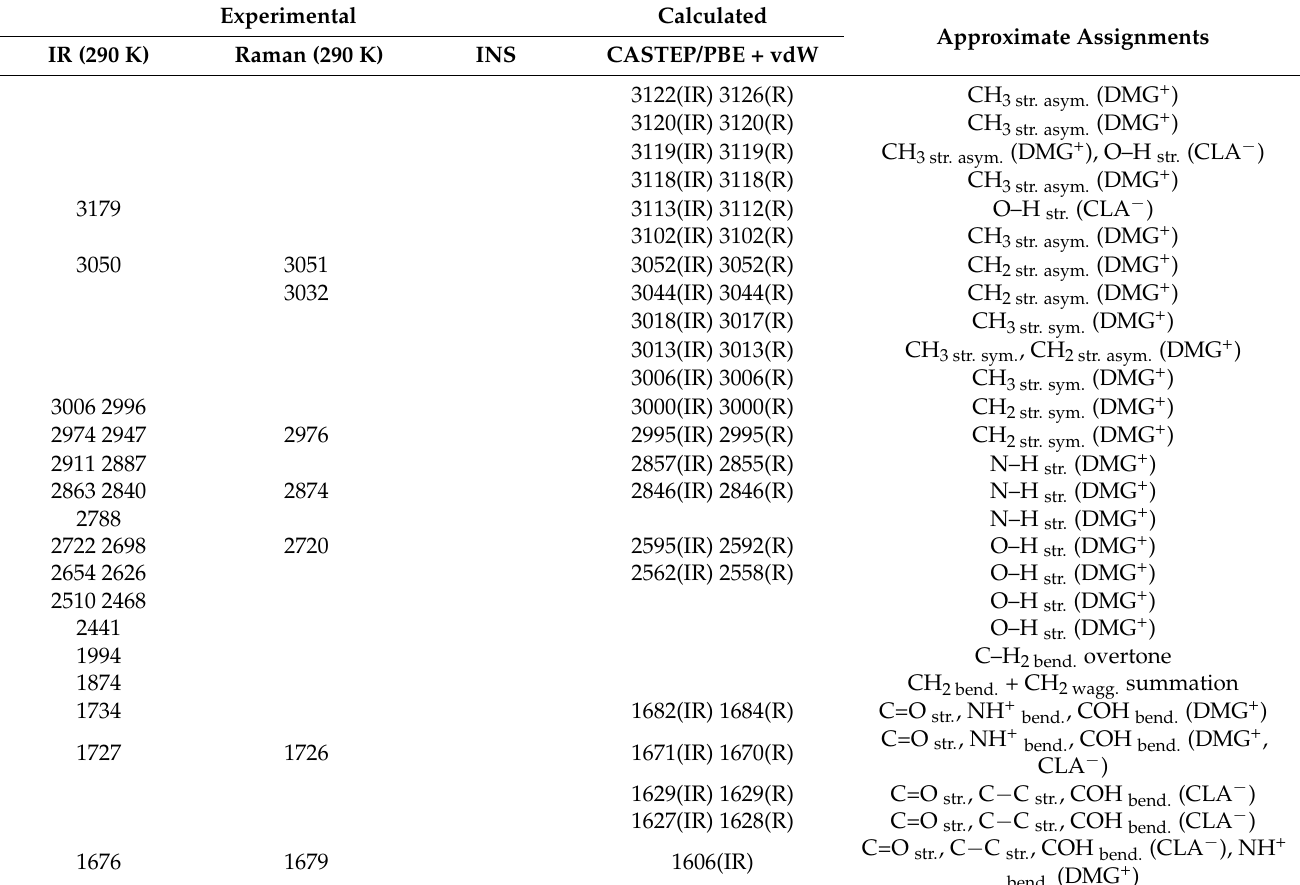
Figure 8. Comparison of experimental and calculated (at PBE + vdW level): ( a ) IR and ( b ) RS spectra for the N,N-dimethylglycine–chloranilic acid complex in the region of 3500–450 cm − 1 . Table 6. Observed and calculated frequencies for the N,N-dimethylglycine–chloranilic acid (DMG + –CLA − ) co-crystal (cm − 1 ). The structure is centrosymmetric; thus, vibrations active in IR are not active in Raman and vice